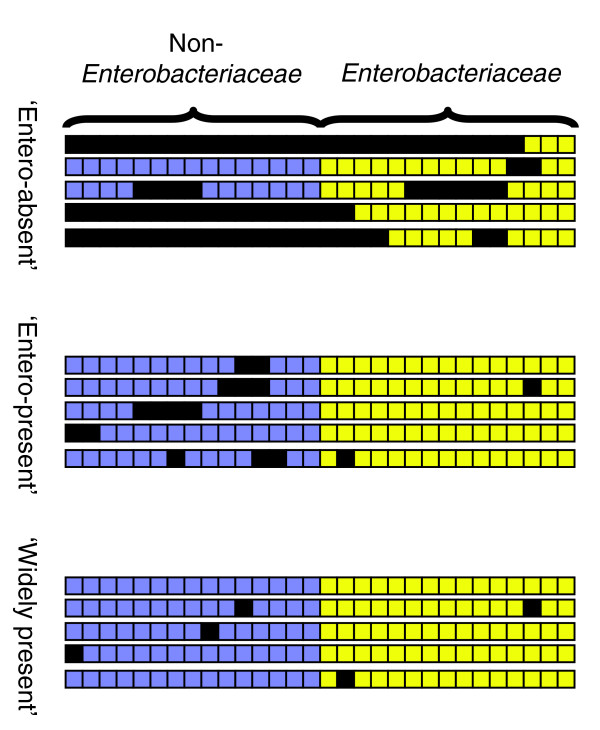
Classifying E. coli K12 transcription factors into three groups based on their conservation across E. coli K12 close and remote relatives. The first group of TFs includes TFs that appear in most of the 30 bacteria in our study ('widely present'). A TF was included in this group if it appears in at least 14 of the 15 Enterobacteriaceae and in at least 14 of the 15 non-Enterobacteriaceae genomes. The second group includes those TFs that are present in all closely related Enterobacteriaceae genomes and are absent only from the more distantly related non-Enterobacteriaceae organisms ('entero-present'). A TF was classified into this group if it was present in at least 14 of the 15 Enterobacteriaceae and was absent from two or more of the 15 non-Enterobacteriaceae. The last group includes those TFs that are absent from some of the most closely related Enterobacteriaceae. TFs were classified into this group if they are absent from at least two of the 15 Enterobacteriaceae ('entero-absent'). For each of the three groups, five examples of conservation patterns of TFs that would be classified into that group are illustrated. Yellow and purple boxes represent presence of a TF in Enterobacteriaceae and non-Enterobacteriaceae, respectively. Black boxes indicate absence of the TF from an organism. Each column illustrates an example of presence/absence pattern that would result in classification of a TF in one of the three classes.